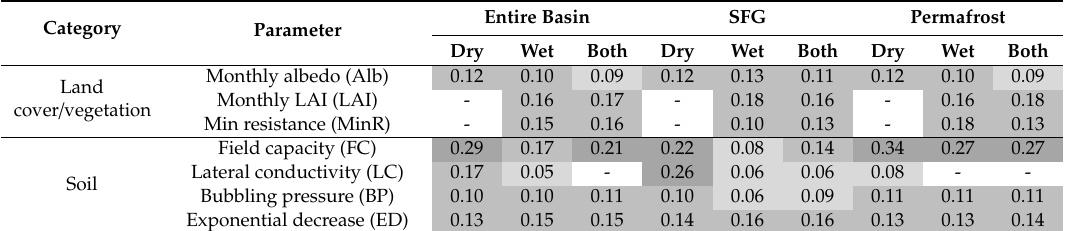
Table 1. Sensitivity indices of the DHSVM parameters for each spatial and temporal combination.